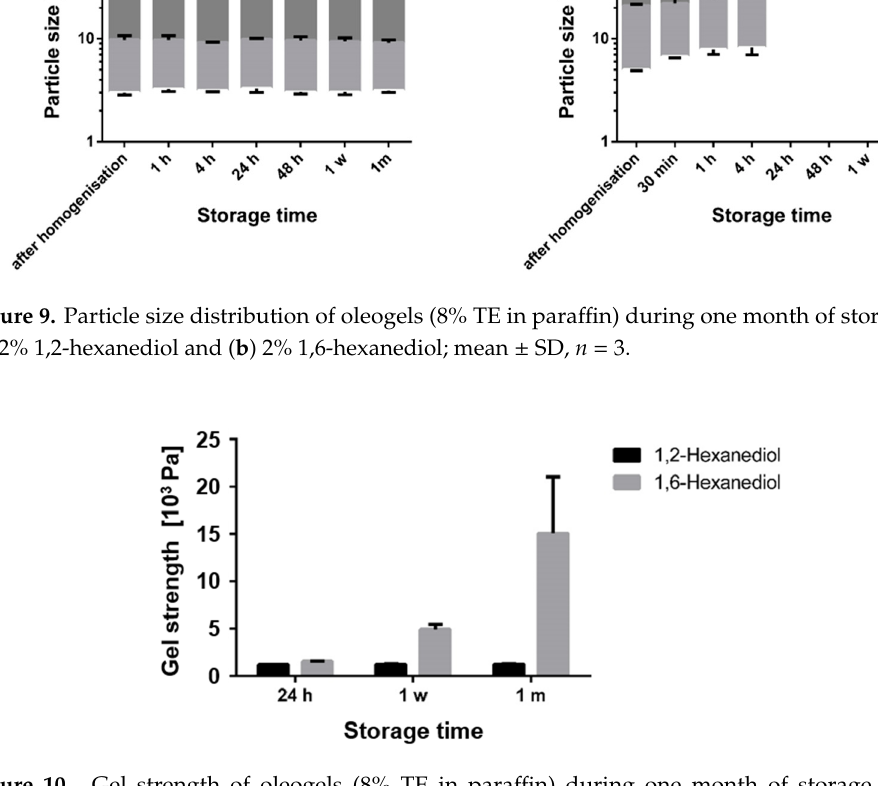
Figure 10. Gel strength of oleogels (8% TE in para ffi n) during one month of storage with 2% 1,2-hexanediol and 1,6-hexanediol; mean ± SD, n =